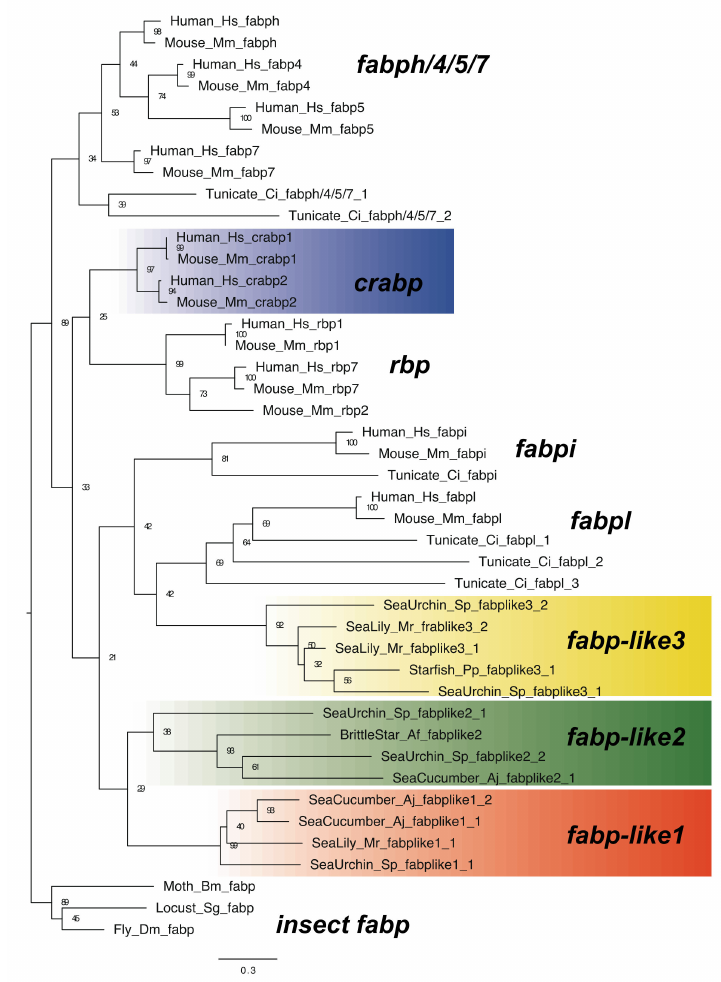
Figure 6. Maximum-likelihood phylogenetic tree for iLBP genes. We retrieved the dataset of iLBP genes (Table S6, Supplementary Dataset 6) and constructed phylogenetic tree as described above. Each color box indicates the gene clade of crabp (blue), fabp-like1 (orange), fabp-like2 (green) and fabp-like3 (yellow). Abbreviation: Fly; Drosophila melanogaster , Locust; Schistocerca gregaria and Moth; Bombyx mori